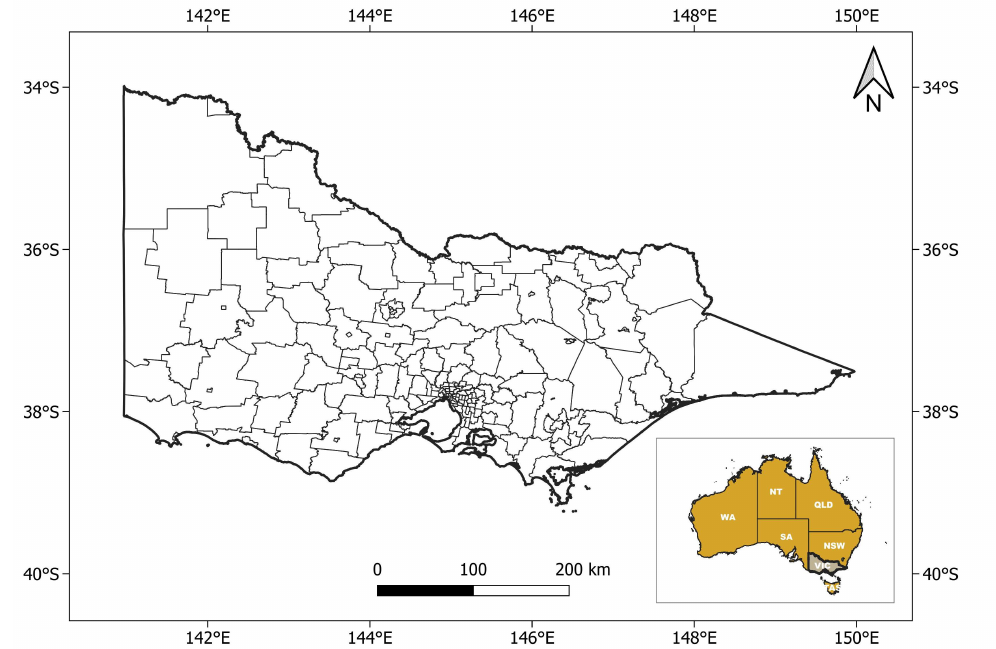
Figure 1. Victorian LGAs mapped in World Geodetic System (WGS) 84 coordinate reference system. These individual LGAs are used in mapping urban green space abundance, developing Urban Green Space Index ( UGSI ) and Per Capita Green Space ( PCGS ) employing demographic data.